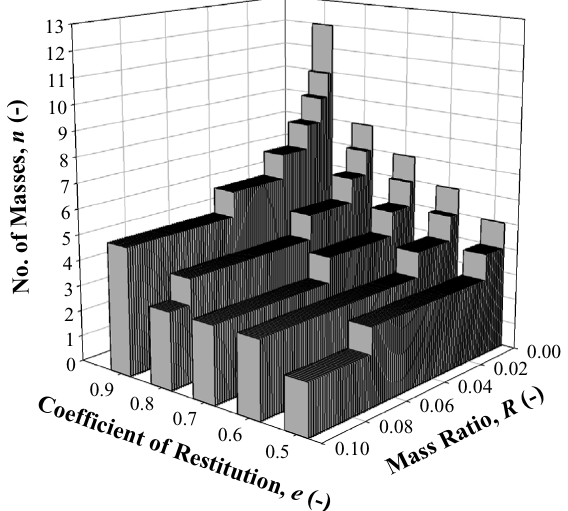
Fig. 8. Plot of optimum number of masses to maximise velocity of the uppermost mass versus mass ratio and coefficient of restitution, for a vertically-stacked MVG system. (-) means non-dimensional.